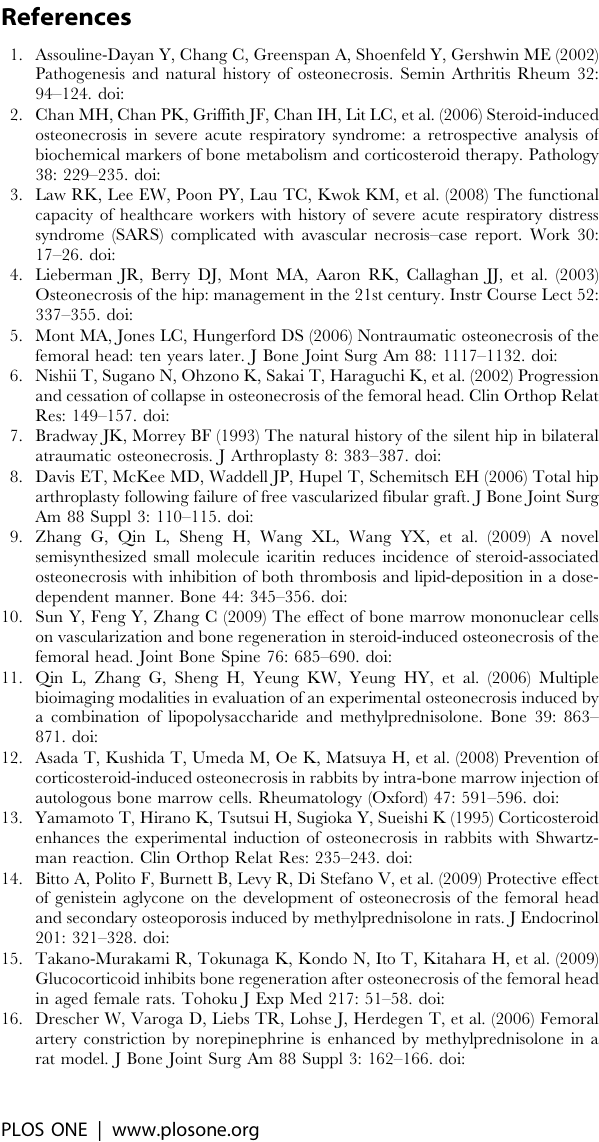
Figure S1 SAON induction in bipedal emus. A: Intrave- nous injection of LPS; B: Intramuscular injection of MPS; C: General conditions of emus are normal post SAON-injection of lipopolysaccharide and methylprednisolone using the current SAON induction protocol. Figure S2 A specific posture fixture is developed for in vivo bio-imaging examination of emu hips to obtain highly reproducible images. A: Firstly, the emu is maintained at left lateral lying position, which fits the size of MRI examination bed; B: the bilateral lower limbs are kept parallel by inserting a piece of shaped foam board between the two legs in the custom- made posture fixture, which reduces variation in positioning during the repeated in vivo radiographic examinations; C: Emus are ready for MRI